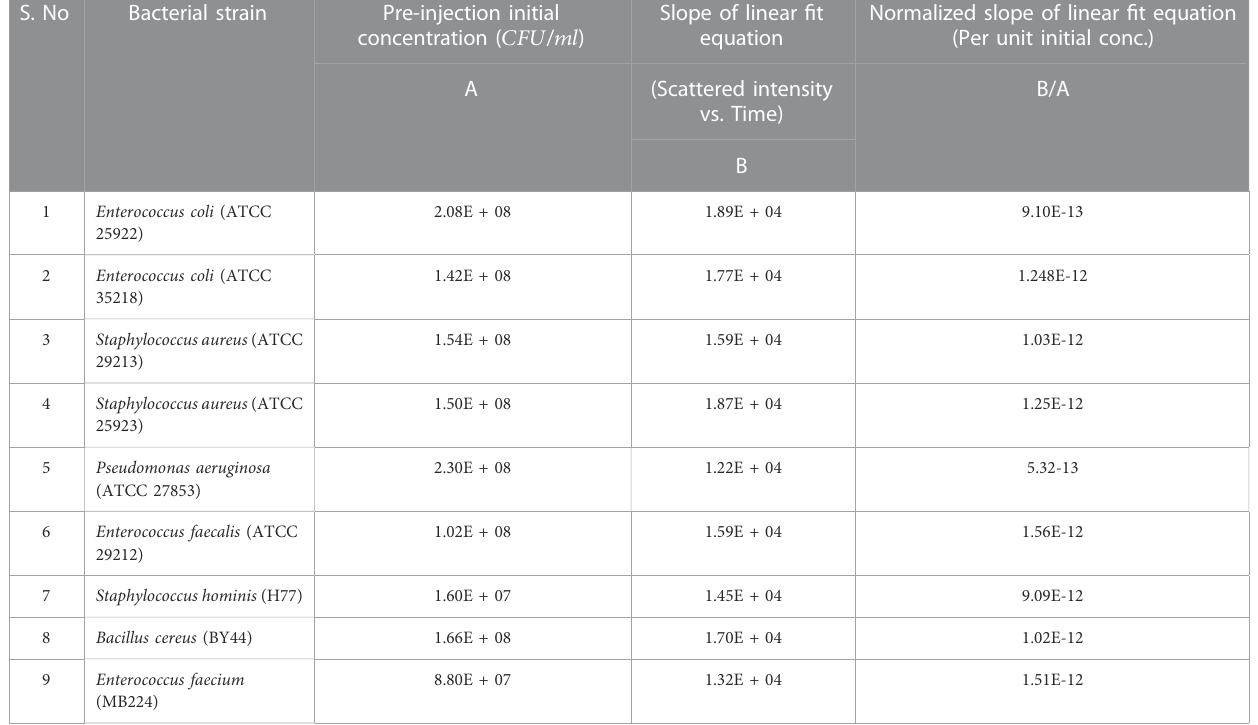
Figure 3) due to increasing concentrations of PBS solution and the nine bioaerosols (the nine subplots starting from the top row, third from left to right, to the bottom row third from left, Figure 3) in the chamber shows the backscattered light intensity increases with time as the concentrations of scatterers increase in the measurement volume, suggesting a direct linear relationship between the concentration of scatterers and the backscattered light intensity. The effects of the start and stop of bioaerosol injection in each plot are evident as the initial gap in scatter near the origin of axes and the varying extents of scatter in the negative ( x,y ) axes due to the different concentrations of injected aerosols. In addition, we see that the location of the scattered beam positions projected on the 2D photodetector also increases with increasing concentrations of injected aerosols (of PBS and the nine bacterial strains).